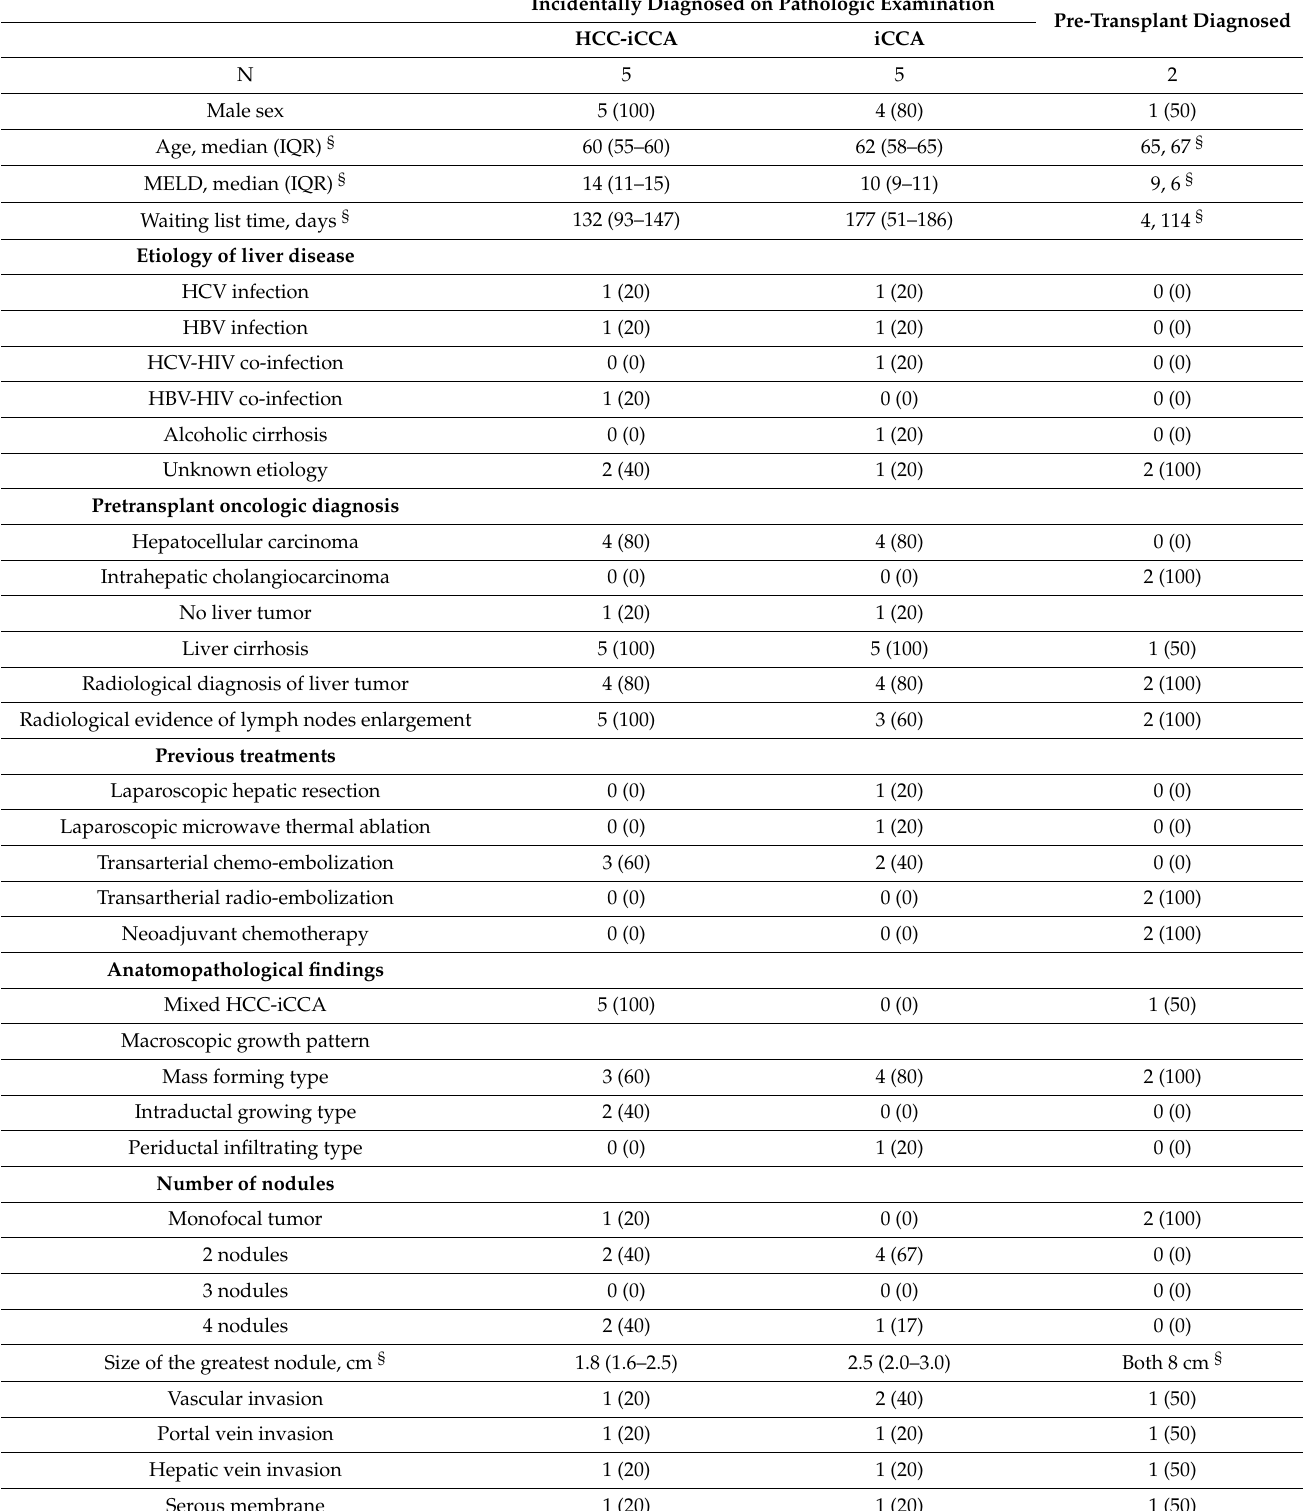
Table 1. Clinical and pathological characteristics of 12 patients transplanted with HCC-iCCA or